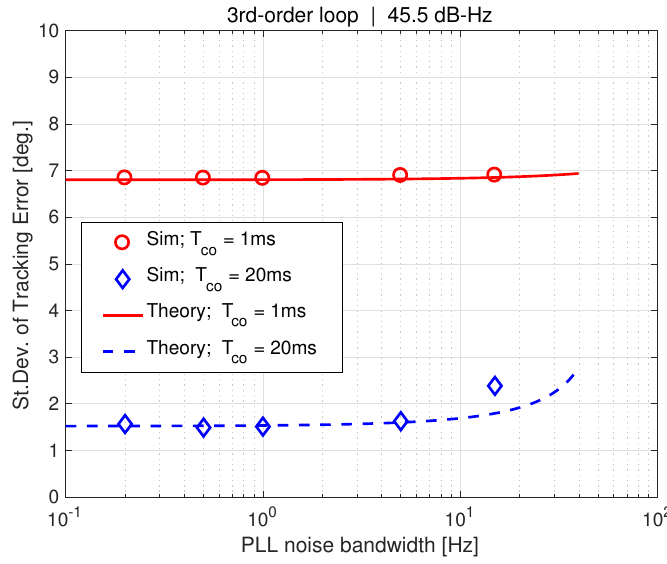
Figure 8. Sigma tracking error vs. PLL